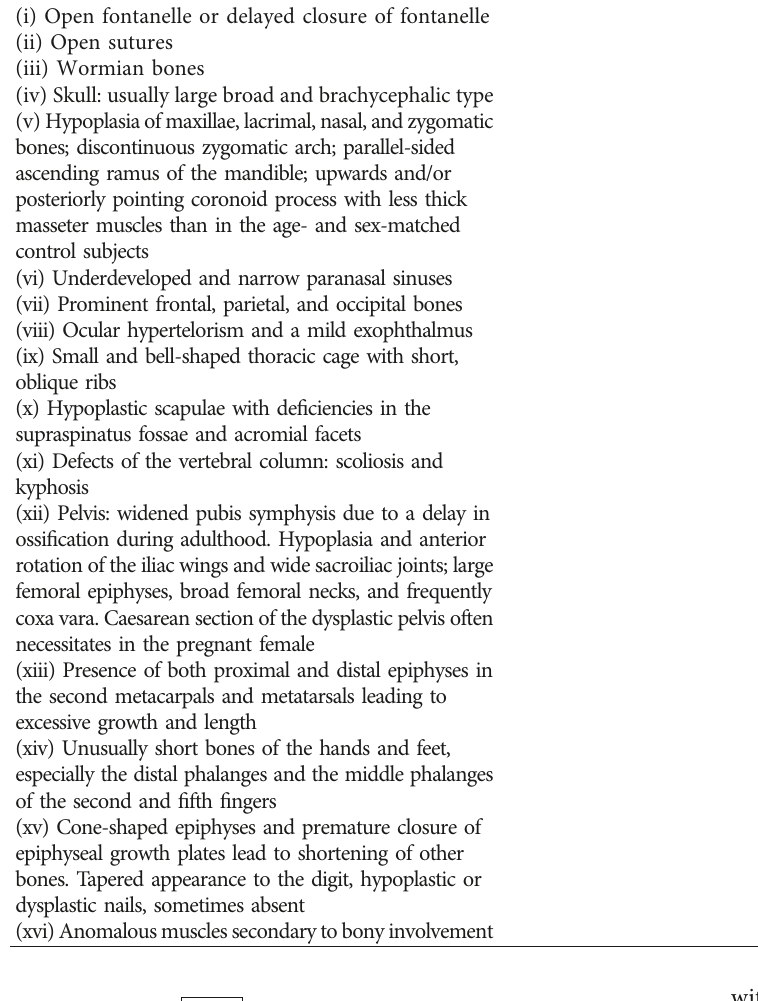
Clinical findings Dentoalveolar characteristics